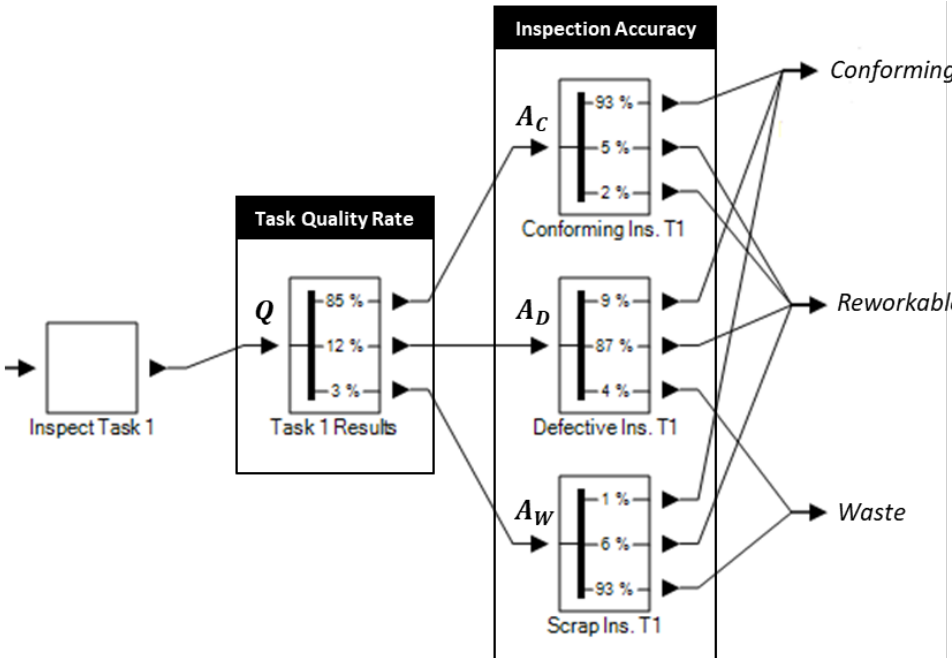
Figure 3. Example of modeling of inspection process using DES in Simphony for a single task with only one detectable defect.